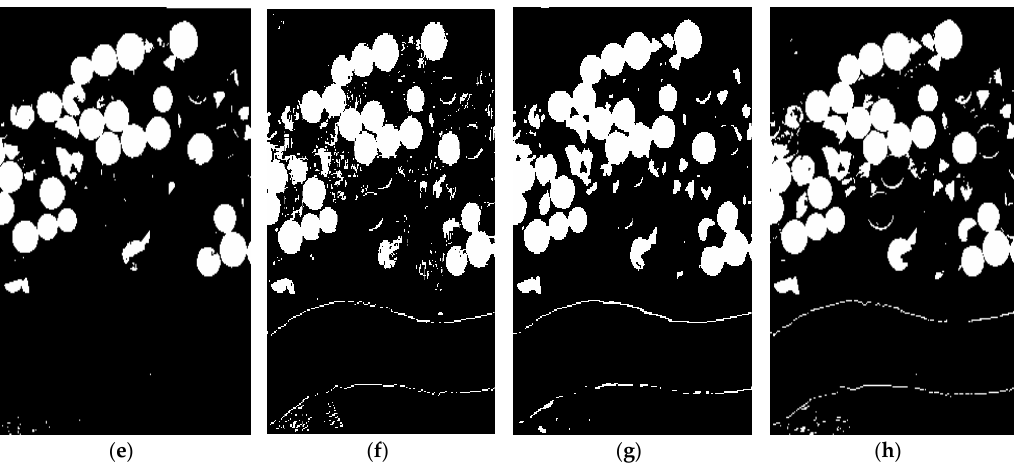
Figure 18. The change detection maps of different methods for the Hyperspectral-Farmland dataset. ( a ) CVA-SVM, ( b ) MAD-SVM, ( c ) PCA-SVM, ( d ) IR-MAD -SVM, ( e ) SFA-SVM, ( f ) 3D-CNN, ( g ) Proposed Method, and ( h ) Ground Truth. White and black colors indicate the change and no-change areas, respectively.